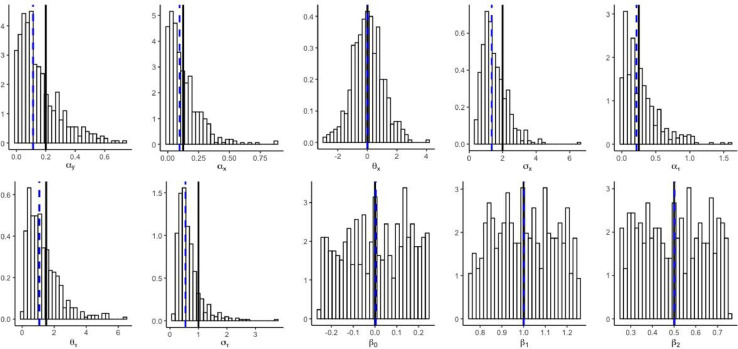
Histogram of posterior parameter estimate for the OUOUCIR model in ouxy. The vertical line in bold in each panel represents the true value and the vertical dashed line is the posterior median. The R script to generate the plots for this simulation can be accessed at online supplemental posthistououcir.r